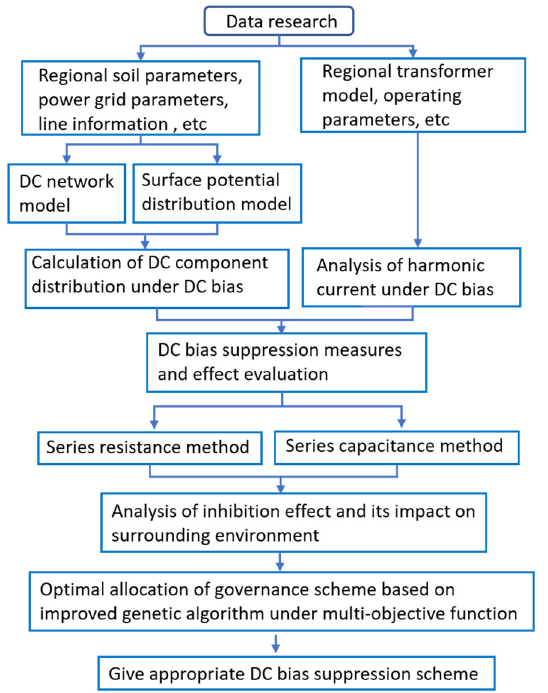
Figure 6. Flow chart of DC bias calculation and suppression scheme.